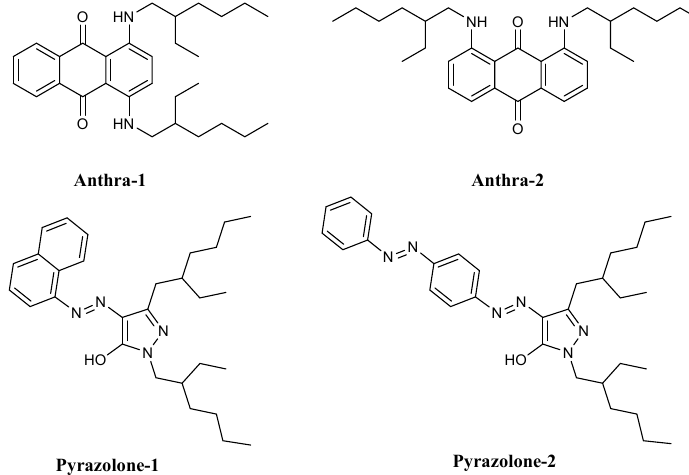
Figure 1. Molecular structures of the four synthesized dyes.